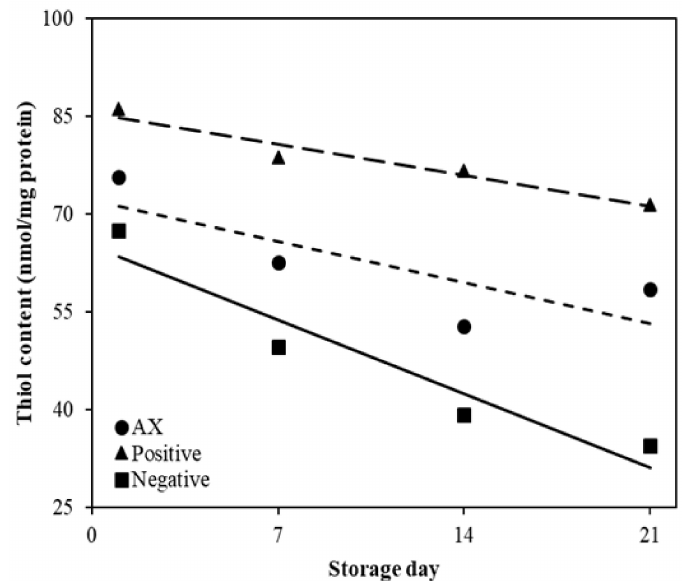
Figure 2. Effect of antioxidants on protein oxidation of emulsified sausages. The solid lines were for the negative control, the large dashed line for the positive control, and the small dashed line for AX. Negative: without antioxidant; Positive: with 200 mg/kg mixture of BHT and BHA (1:1, w / w ); AX, with 400 mg/kg